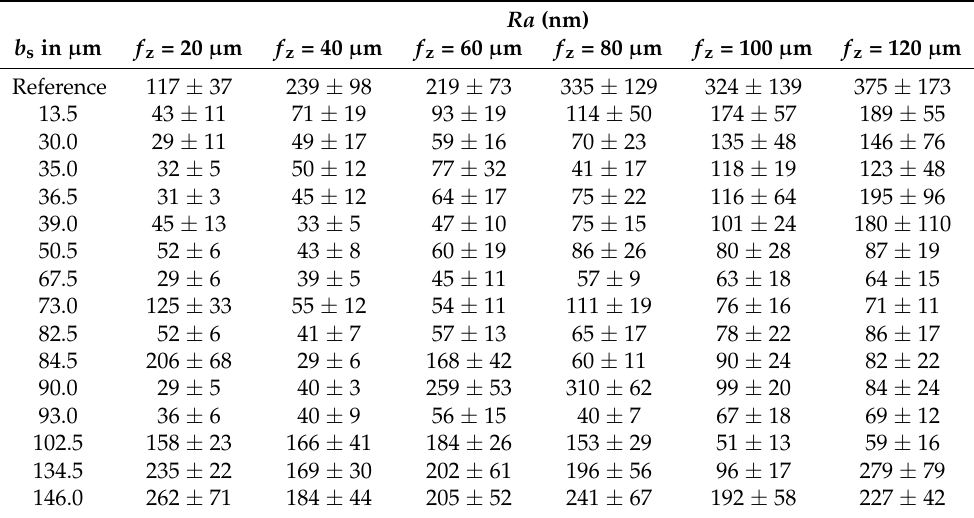
Figure 8. ( a ) Arithmetic mean roughness, Ra , for different values of the length of parallel land, b s , and the varied feed per tooth, f z ; ( b ) Influence of increasing length of parallel land, b s , on resulting roughness at f z = 20 µ m and 120 µ m. Table 4. Arithmetic mean roughness, Ra , and the corresponding standard deviation for the experi- mental tests